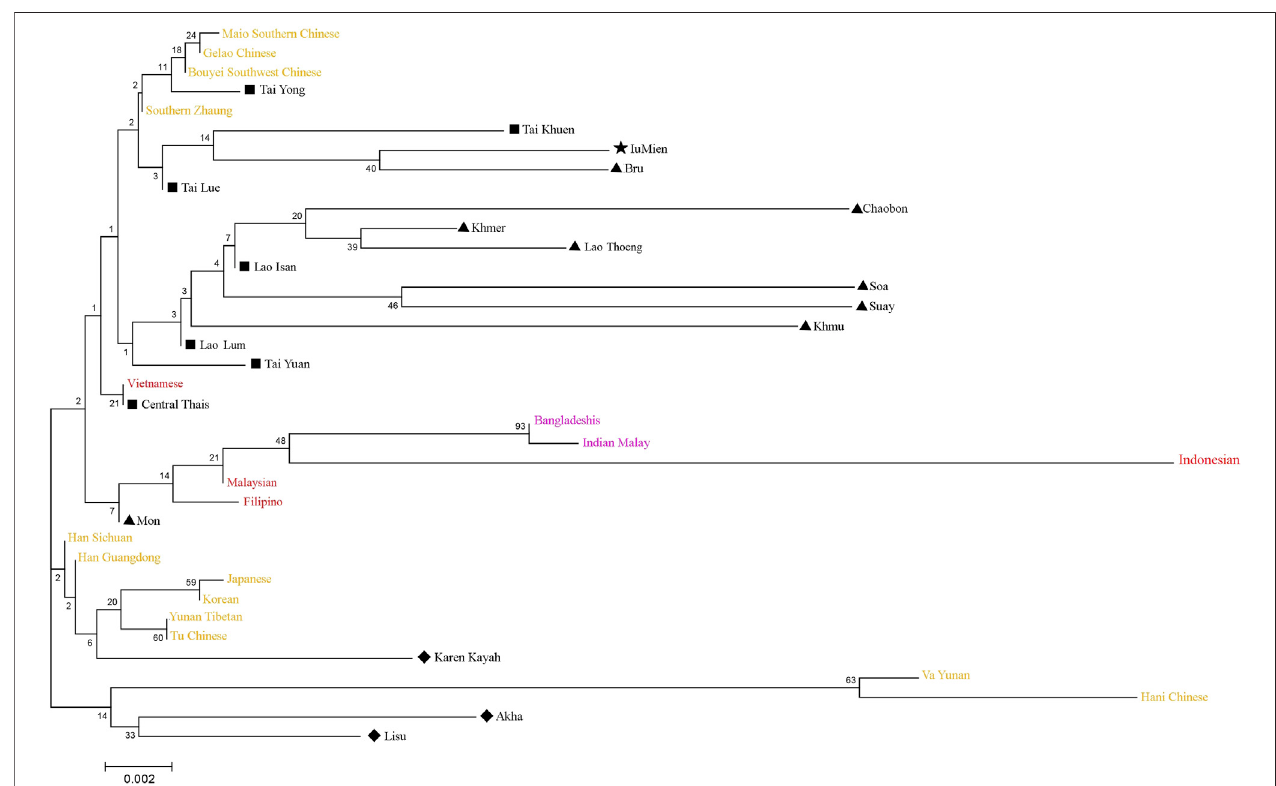
FIGURE 8 | Neighbor-joining tree constructed from F ST genetic distance based on the allelic frequencies of 13 STR loci among total 37 populations. The comparativepopulationsfromChina/EastAsia,SoutheastAsiaandSouthAsiawererepresentedbyyellow,redandpurple,respectively.PopulationsfromThailandwere indicated with black and different symbols. Diamonds, triangles, star, and squares represent ST-, AA-, HM-, and TK-speaking populations, respectively.